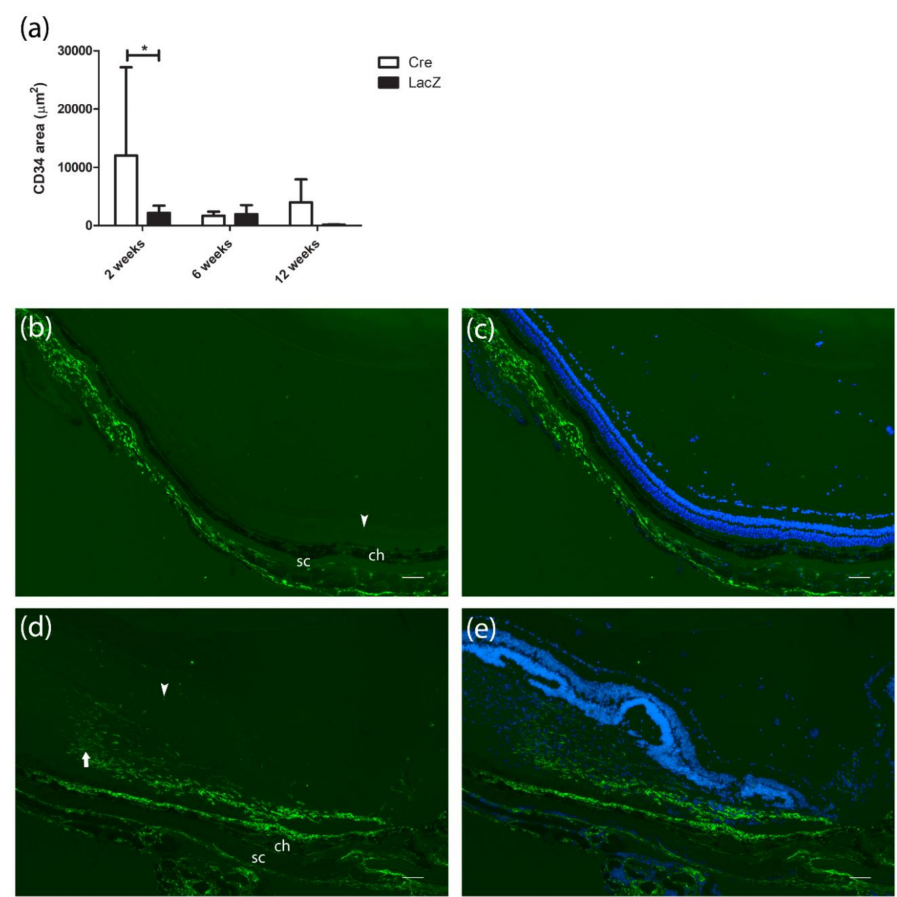
Figure 3. Comparison of CD34 positive endothelial cells (green) in Cre- and LacZ -injected mice with nuclear counterstain 4 (cid:48) ,6-diamidino-2-phenylindole DAPI (blue). ( a ) CD34 positive area in the retina and subretinal membranes. Results are presented as mean ± SD. * p ≤ 0.05. ( b , c ) Few normal deep retinal vessels (arrowhead) in the retina two weeks after LacZ gene transfer. ( d,e ) Single retinal endothelial cells and massive subretinal neovascular membrane (arrow) under the swollen retina two weeks after Cre injection. Scale bar is 100 µ m. ch: Choroid, sc: